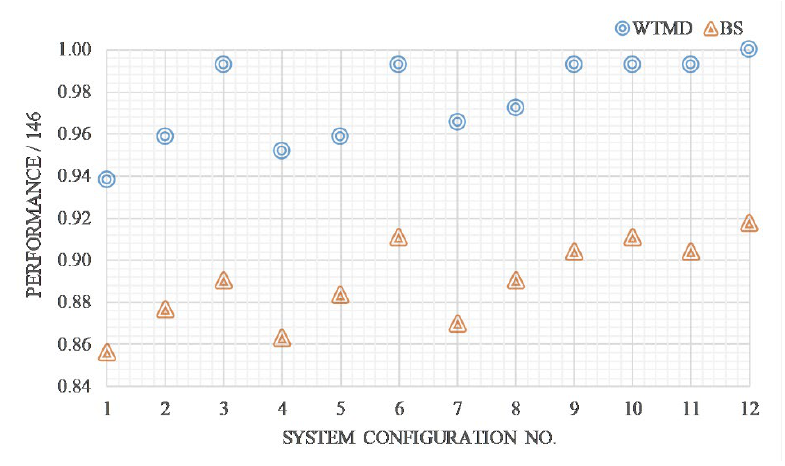
Figure 7. Ratio between the system performance and the target value of 146 pax/h .